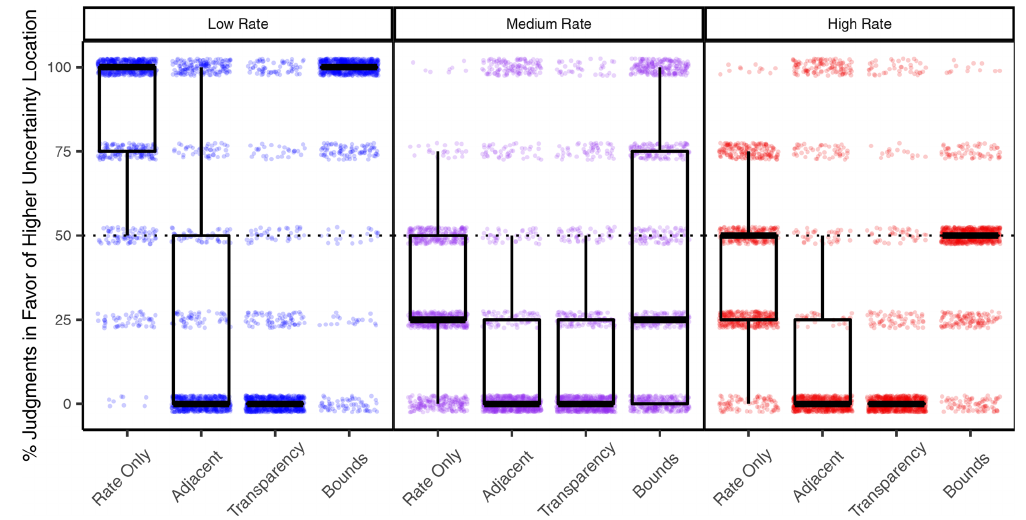
Figure 7. Percentage of trials where the higher-uncertainty location was selected between two locations of equal rate level (surprise trials), grouped by condition and rate level. Boxplots are over mean percentages across participants, by condition. Each dot represents the mean percentage of one participant, slightly jittered to increase